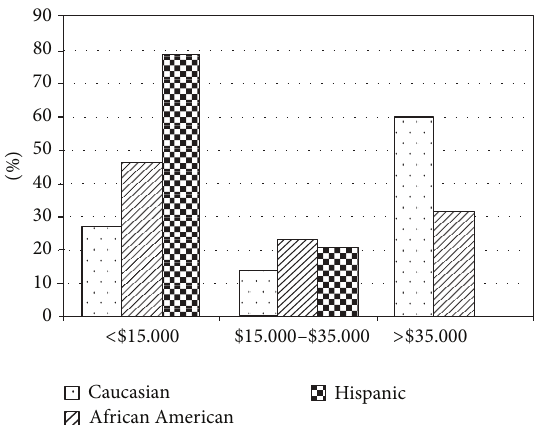
Figure 2: Between the 3 racial/ethnic groups there was a significant difference in income level ( 𝑃 < 0.001 ). Group by group comparison: Caucasian versus African American: 𝑃 = 0.2 ; Caucasian versus Hispanic: 𝑃 < 0.001 ; African American versus Hispanic: 𝑃 = 0.003 .